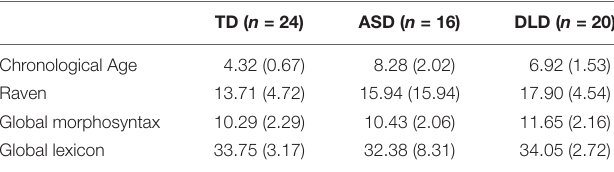
TABLE 2 | Descriptive characteristics of participants.